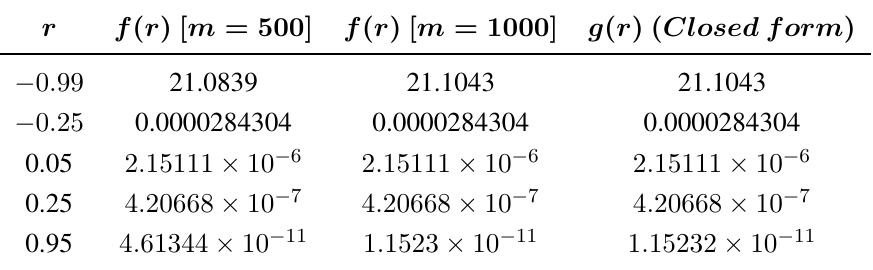
Table 1. PDF of R as evaluated from f ( r ) truncated to m terms and g ( r ) .